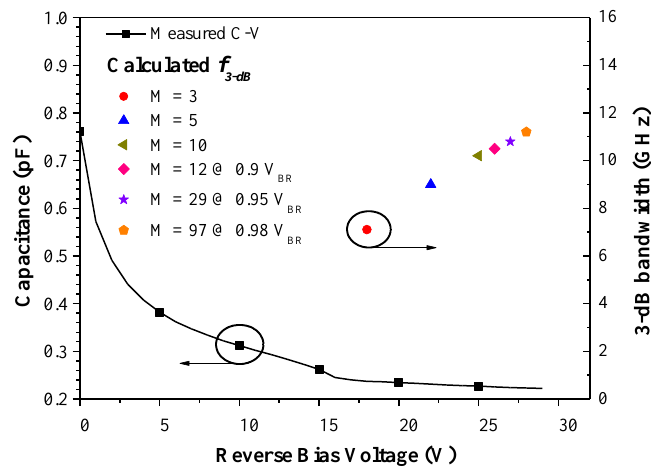
Figure 4. Capacitance and 3-dB frequency ( f 3-dB ) calculated for the proposed APD (bonded on a ceramic sub-mount for testing) as a function of reverse bias voltage.